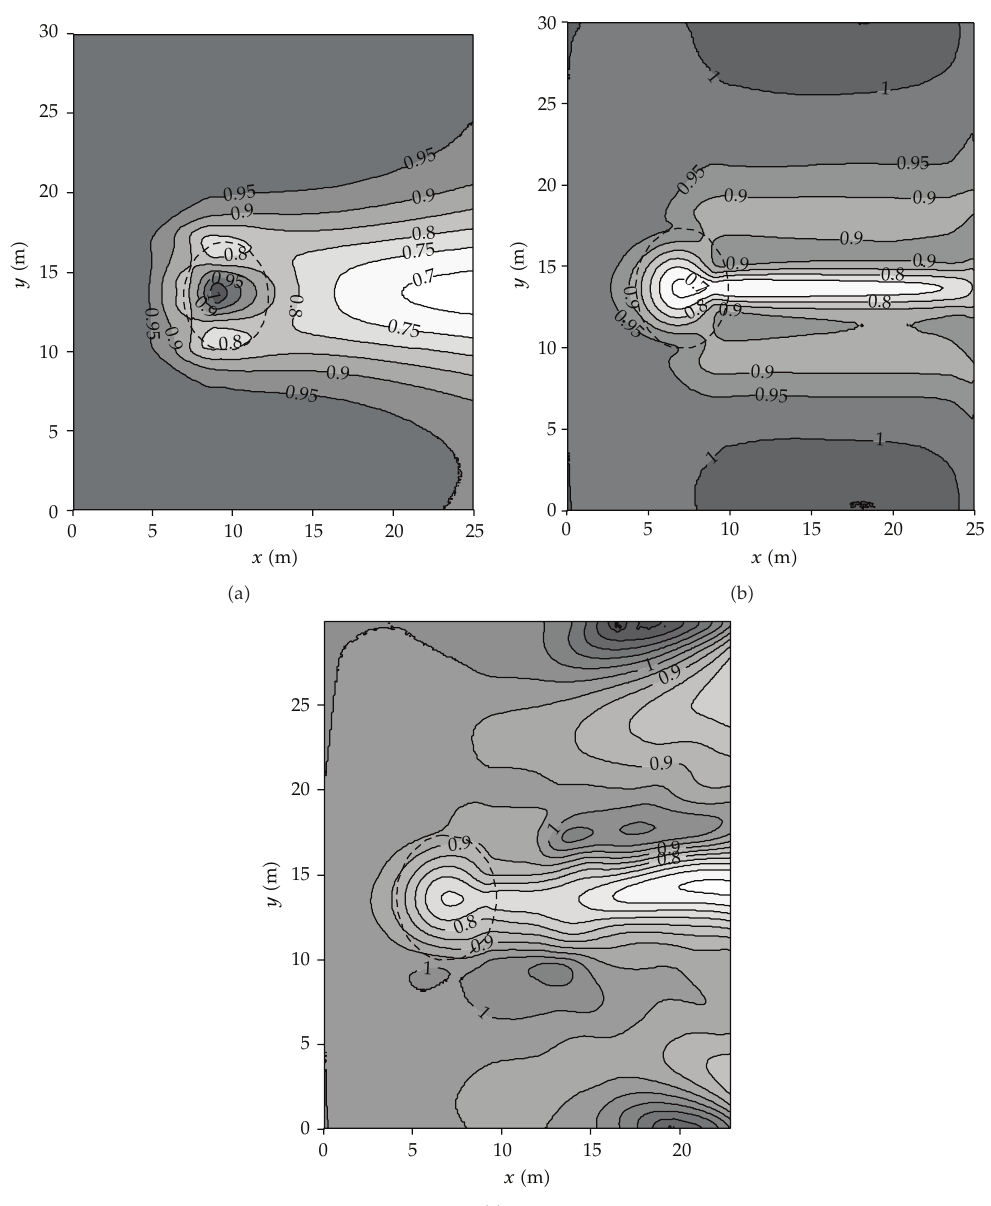
Figure 5: The horizontal distributions of the calculated wave heights (cid:5) a (cid:6) without the two-way iteration, (cid:5) b (cid:6) after the first two-way iteration, and (cid:5) c (cid:6) after the third two-way